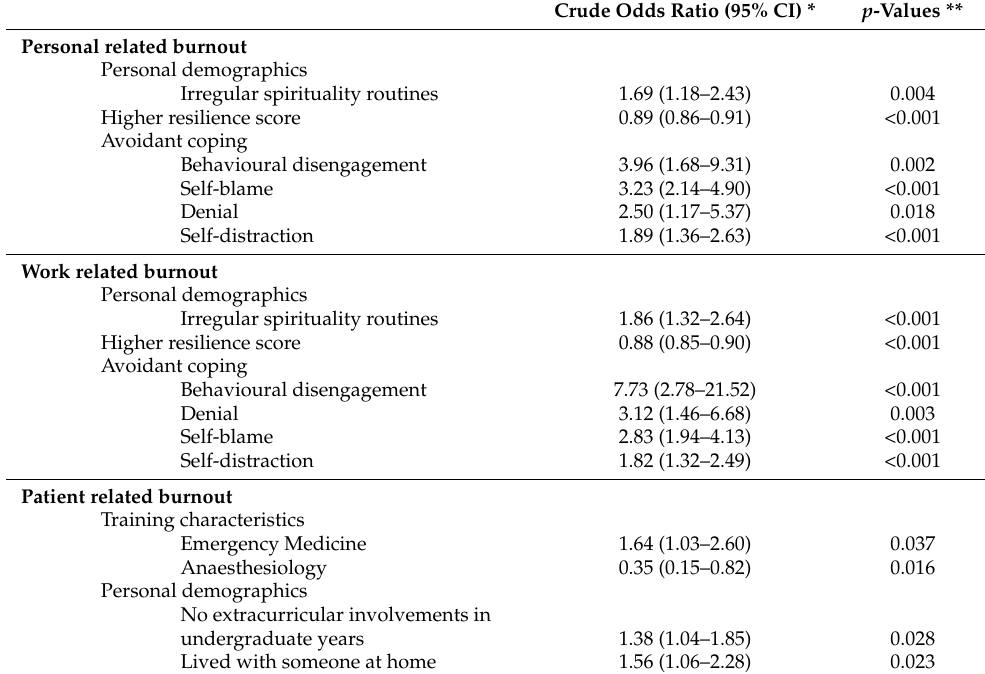
Table 3. Relationship between training characteristics, personal demographics, undergraduate training background and avoidant coping with burnout ( n =